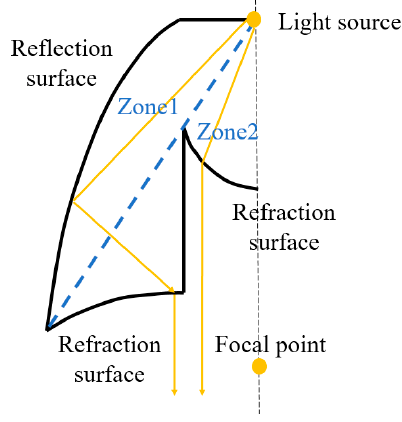
Figure 10. The concept of the new elliptical collimator.